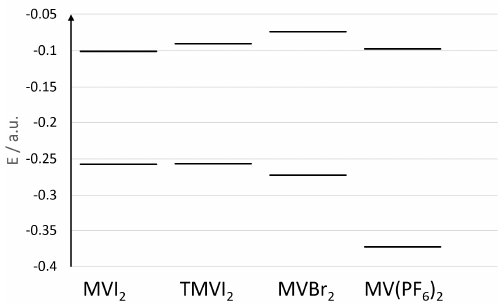
Figure 5. Energies (a.u.) of the HOMOs (lower energies) and LUMOs (higher energies) orbitals of the four systems investigated in dichloromethane .